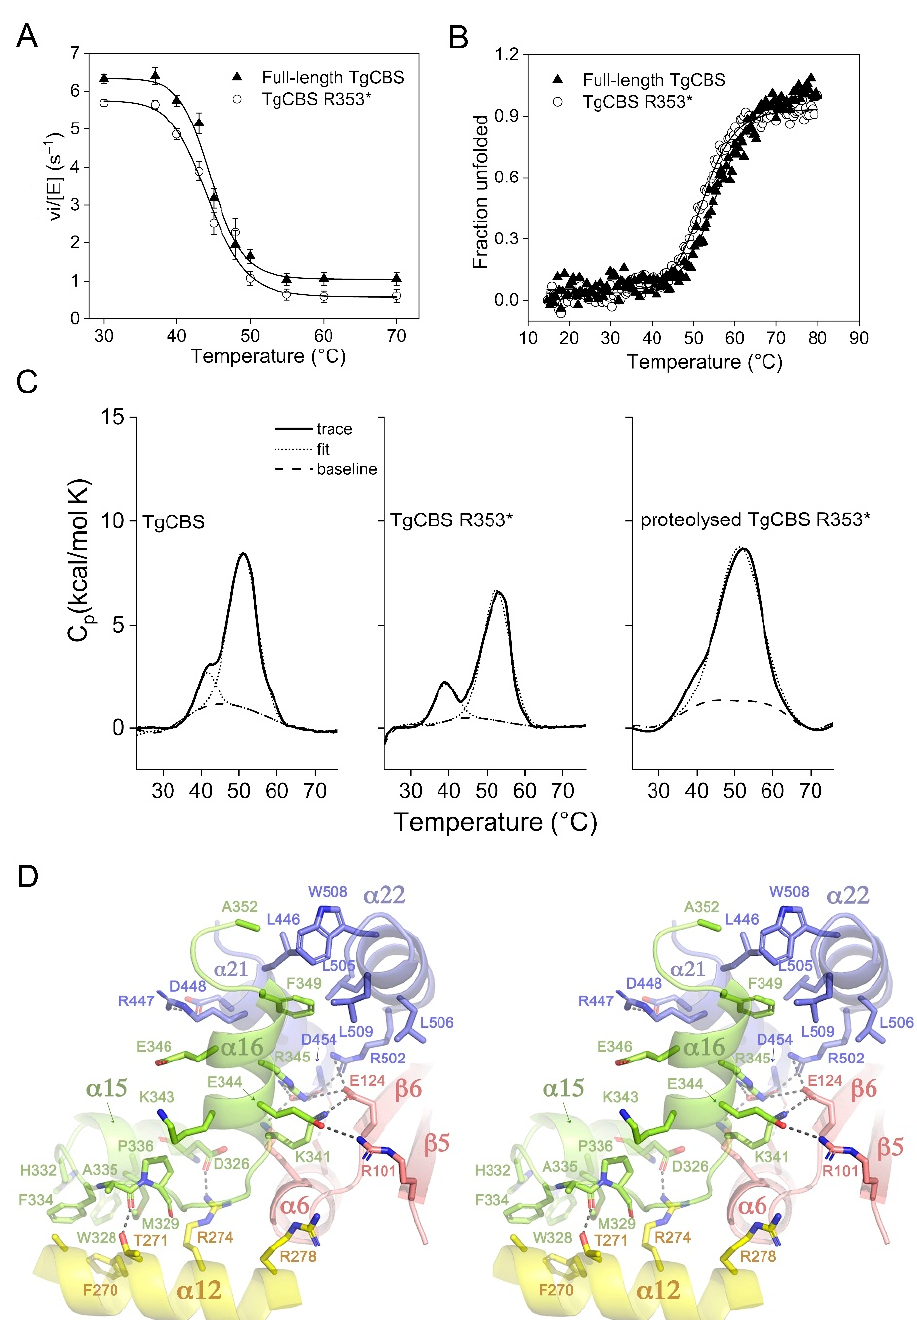
Figure 6. Thermal denaturation of TgCBS variants. ( A ) Effect of thermal pre-treatment of full-length TgCBS (solid triangles) and TgCBS R353* (open circles) on their steady-state initial velocity at saturating concentration of L-Ser and L-Hcys in the canonical reaction. Each data set is relative to